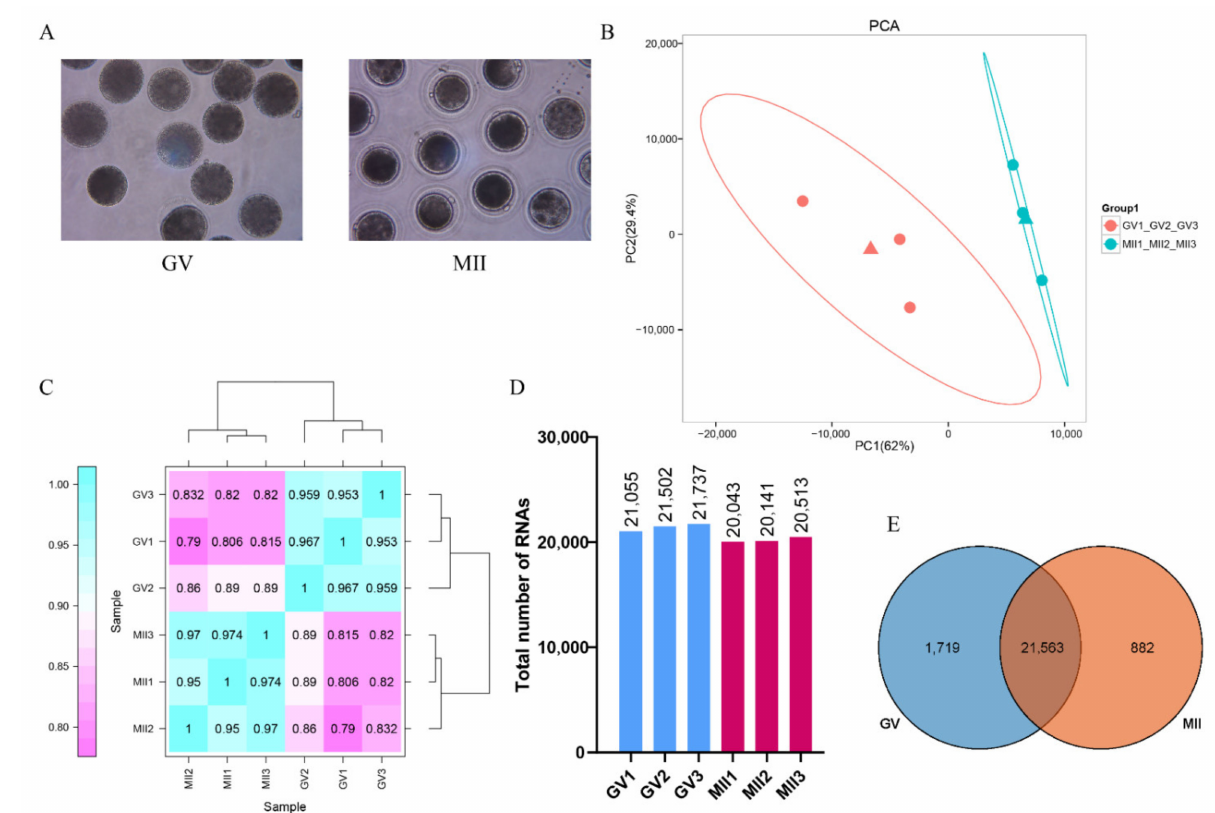
Figure 1. Transcriptional analysis of donkey oocytes at the GV and MII stage. ( A ). Collected donkey oocytes at the GV and MII stage for scRNA-seq. ( B ). Principal component analysis (PCA) of six samples based on gene expression. The red dots indicate GV oocytes, and the blue dots indicate MII oocytes. ( C ). Repeated relevance assessment of the transcriptomes of donkey oocytes. ( D ). The total mRNAs detected by scRNA-seq in GV and MII oocytes. ( E ). Overlap of the expressed genes identified in GV and MII